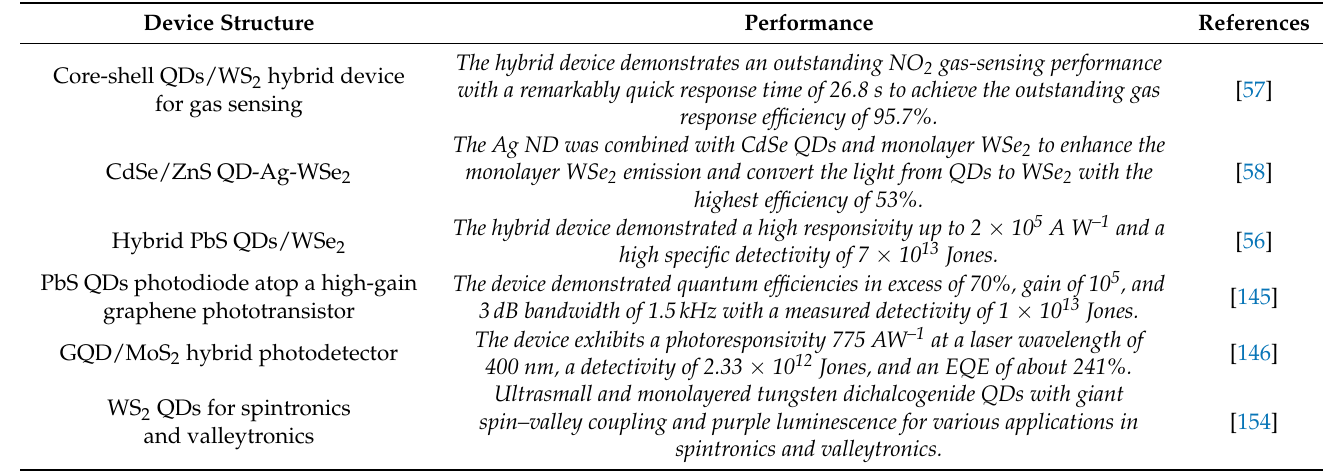
Table 1. Performance of 2D-QDs-based